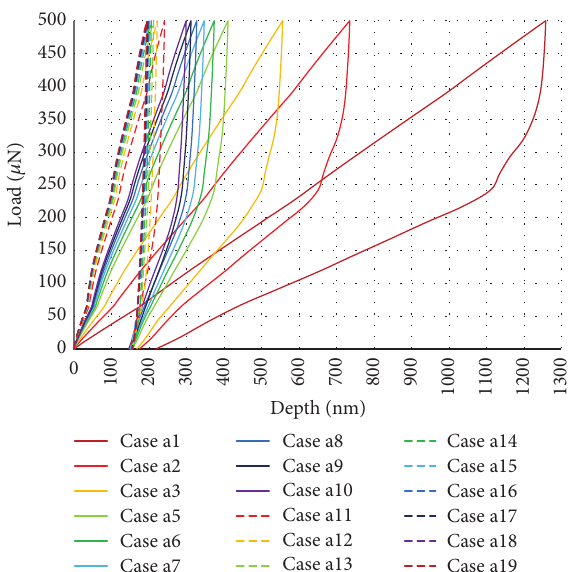
Figure 4: The load-depth curves of series